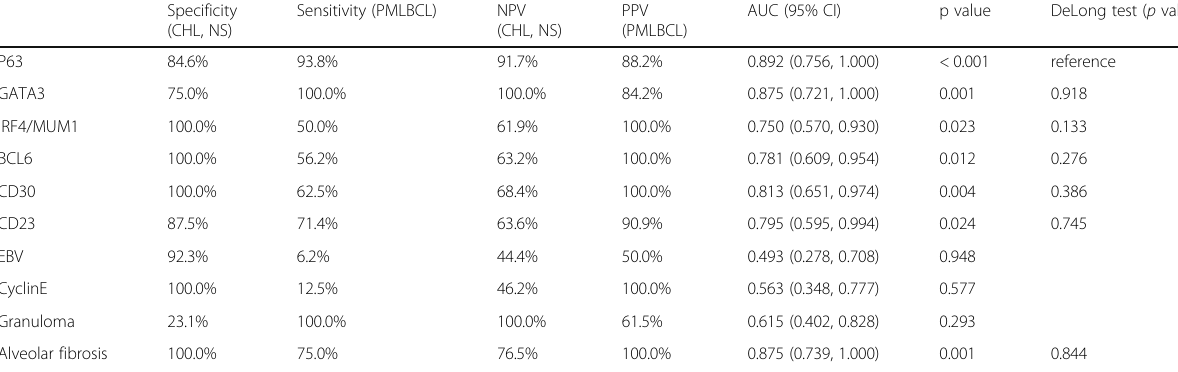
Table 3 Diagnostic utility of pathologic markers in mediastinal B-cell lymphomas Specificity (CHL, NS)